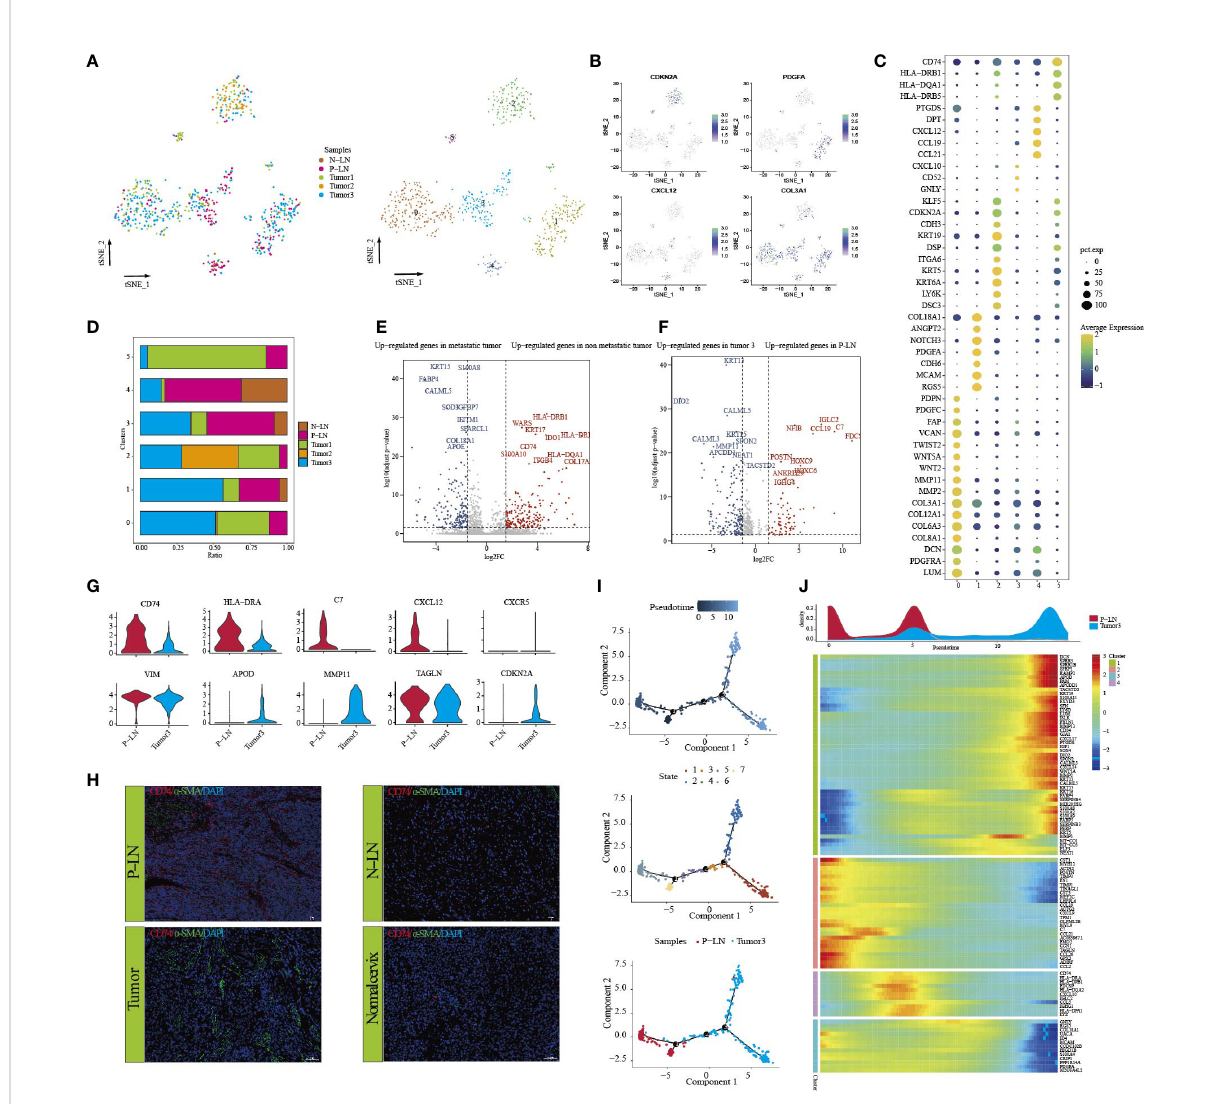
FIGURE 5 Analysis of CAF transition states in primary tumor and metastatic lymph node. tSNE of CAFs, with each cell color-coded for (left to right) the corresponding patient and six clusters of all cells (C0 – C5) (A) . tSNE of marker genes for each cluster (B) . Dot plot of signi fi cant representative genes in six clusters (C) . The proportion of each sample in fi ve samples (D) . Volcano plot showing differentially expressed genes of CAFs between metastatic tumor (tumor 3) and non-metastatic tumors (tumors 1 and 2) (E) . Volcano plot showing differentially expressed genes of CAFs between P-LN and tumor 3 (F) . Violin plots showing the expression difference of signi fi cant genes between P-LN and tumor 3 (G) . Immuno fl uorescence staining of signi fi cant markers in P-LN, N-LN, primary tumor, and adjacent normal tissue. Blue = DAPI, green = a -SMA, and red = CD74 (H) . Pseudotime analysis of CAFs predicated by Monocle 2. Each point corresponds to a single cell, and the color of the dot is distinguished by different times (up), different states (middle), and different samples (down) (I) . Heatmap showing dynamic changes in gene expression along the pseudotime (lower panel). Distribution of CAFs during the transition along with the pseudotime. Samples were labeled by colors (upper panel) (J)